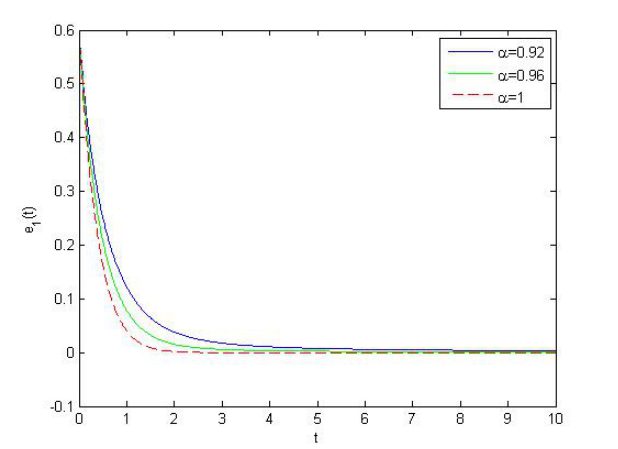
Figure 4. Diagram of the relationship between the different orders of the Lorenz systems and the anti-synchronization of the system in finite-time T .